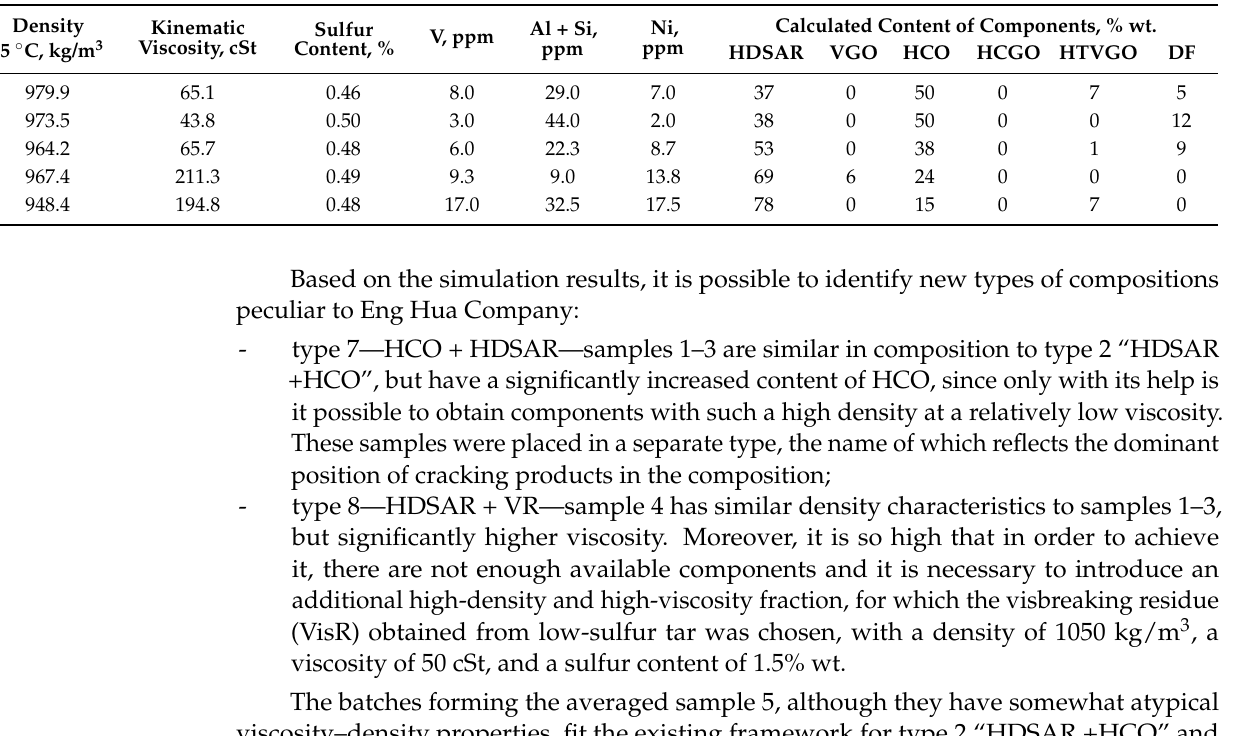
Table 5. Averaged Eng Hua Company batches and simulation results